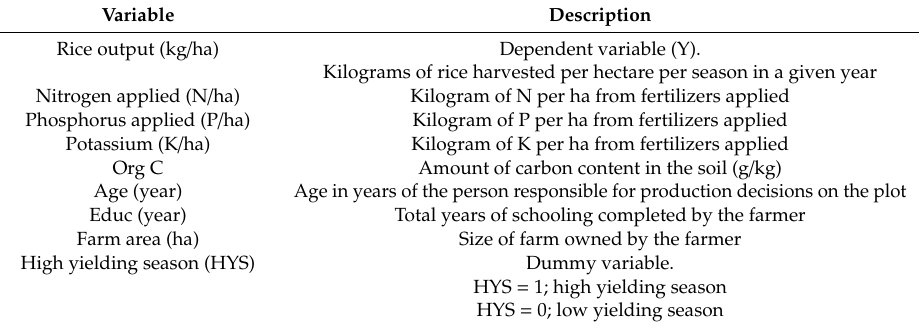
Table 2. Description of